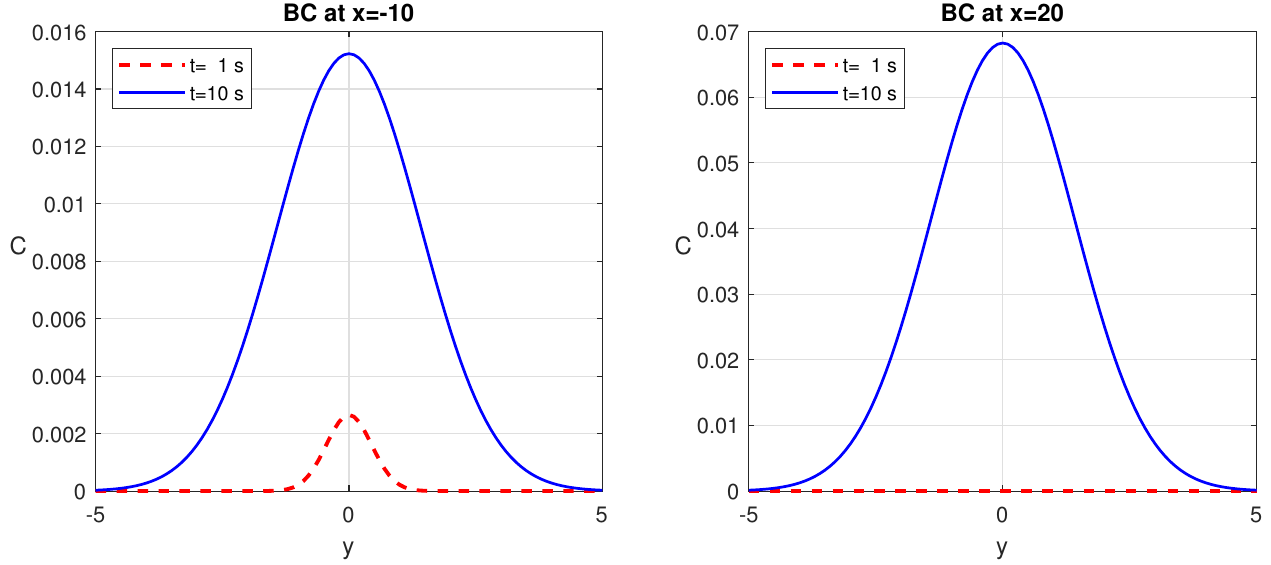
Figure 6. Dirichlet boundary conditions at x = − 10 m ( left ) and x = 20 m ( right ) for problem (36),